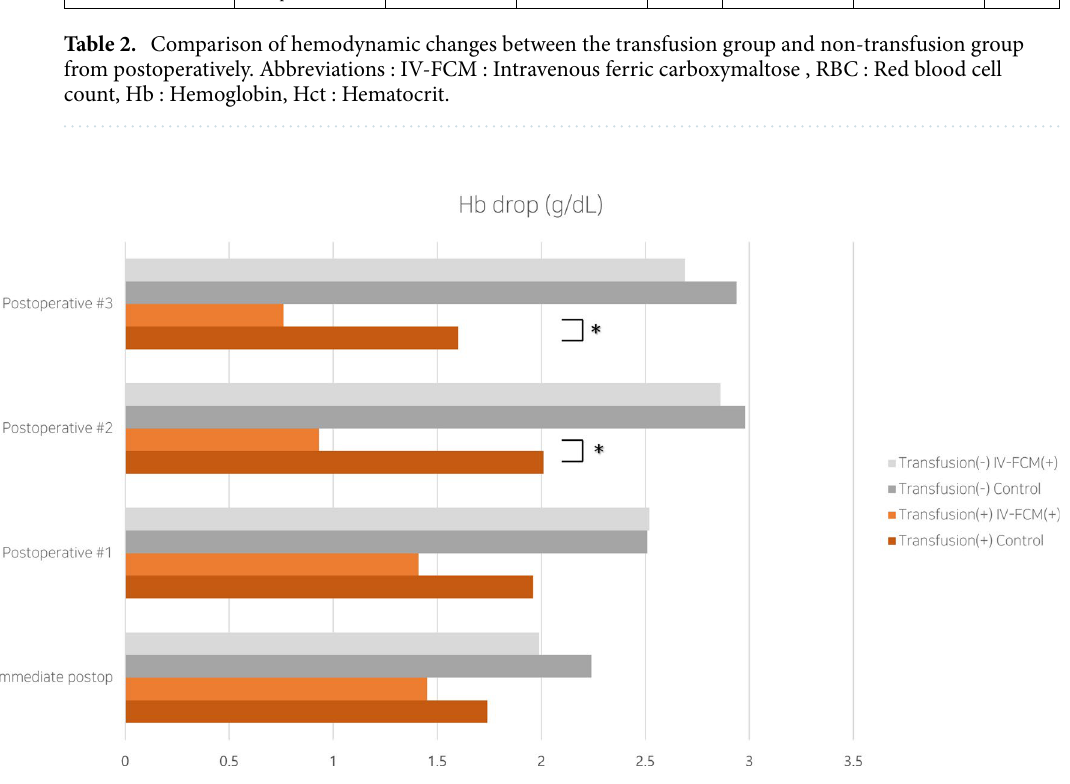
Figure 3. Change of hemoglobin levels illustrated graphically. The difference between the IV-FCM and the control groups in terms of RBC transfusion was significant on postoperative days #2 and #3